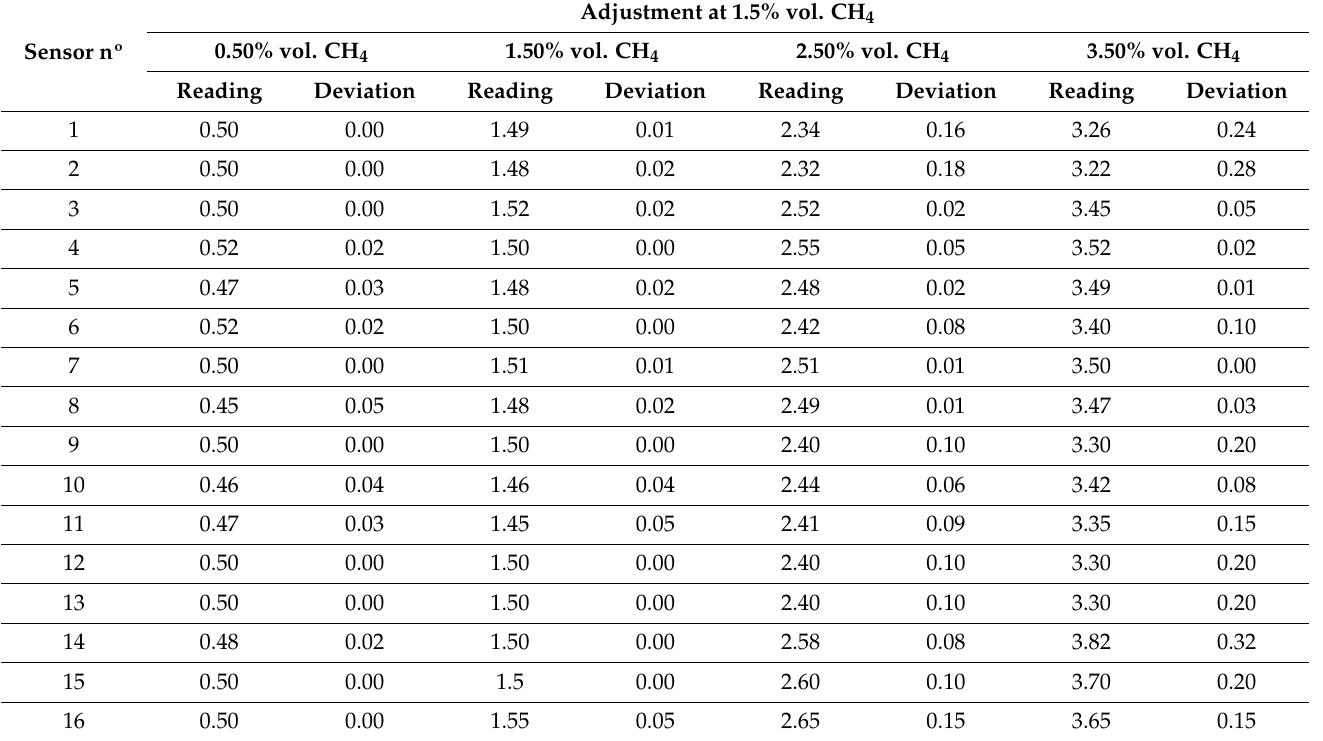
Table 4. Calibration curve—adjustment at 1.5% vol. CH 4